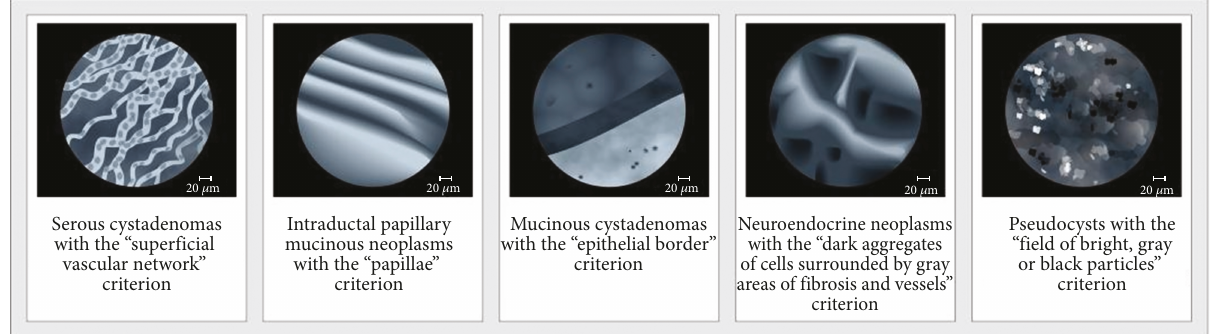
Figure 9: Confocal laser endomicroscopy for evaluation of pancreatic cystic lesions. Adopted from Napoleon et al. [65], Napoleon et al. [56], and Kadayifci et al. [66]. Drawing: Hana